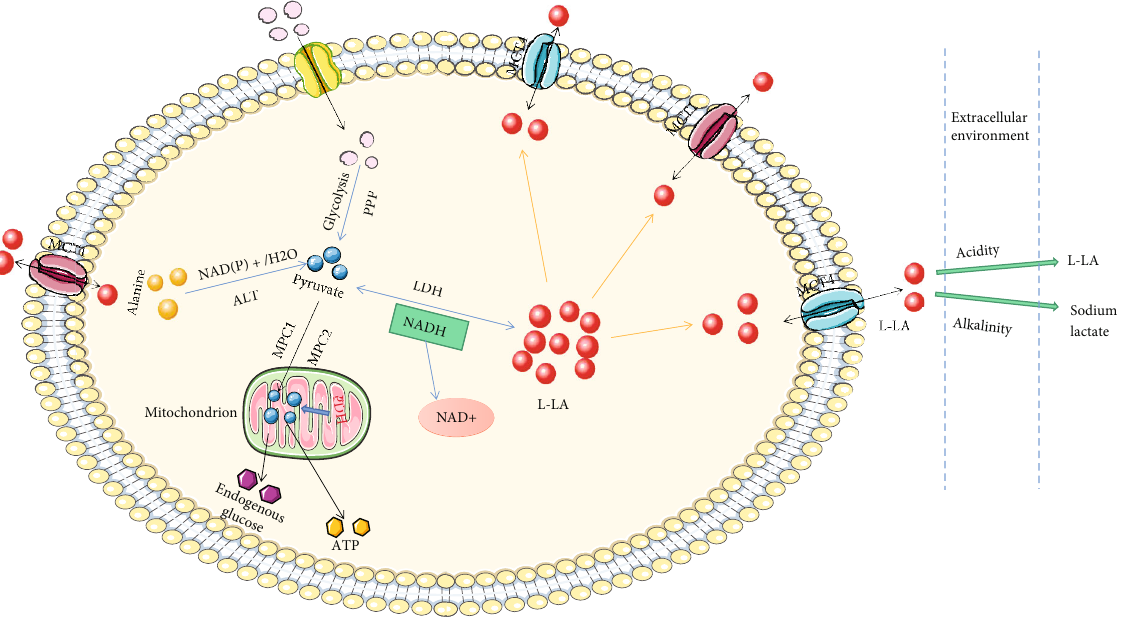
Figure 1: Pyruvate derived from glucose and alanine generates LA under the action of LDH. LA is transported by MCT to maintain the homeostasis of the intracellular microenvironment. The presence of LA outside the cell depends on the pH of the extracellular environment. LA is converted into pyruvate by the reverse action of LDH. MCP1 and MCP2 in the cytoplasm transport pyruvate to mitochondria and are metabolized by PDH into endogenous glucose and ATP. PPP: pentose phosphate pathway; NAD(P) + : nicotinamide adenine dinucleotide (phosphate); ALT: alanine aminotransferase; MPC: mitochondrial pyruvate transporter; PDH: pyruvate dehydrogenase; LDH: lactate